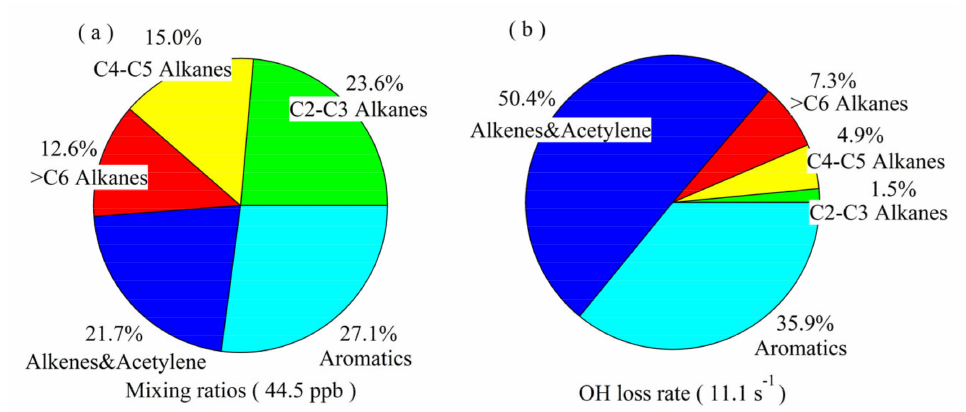
Figure 2. Chemical compositions of average ( a ) NMHCs mixing ratio and ( b ) OH loss rate from online